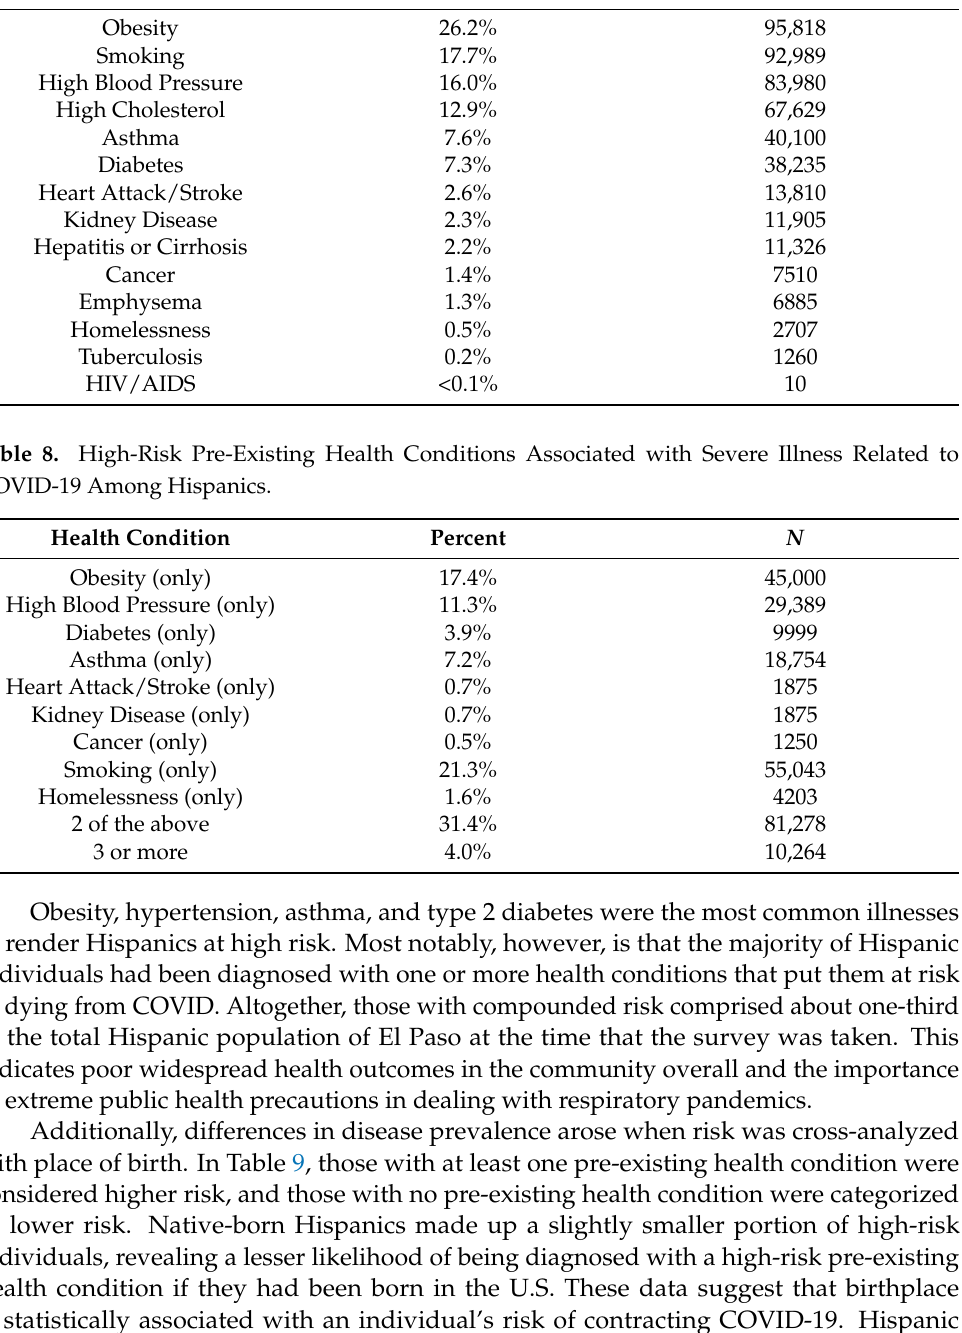
Table 7. High-Risk Illness and Disease Prevalence among Hispanics in El Paso. Health Condition Obesity